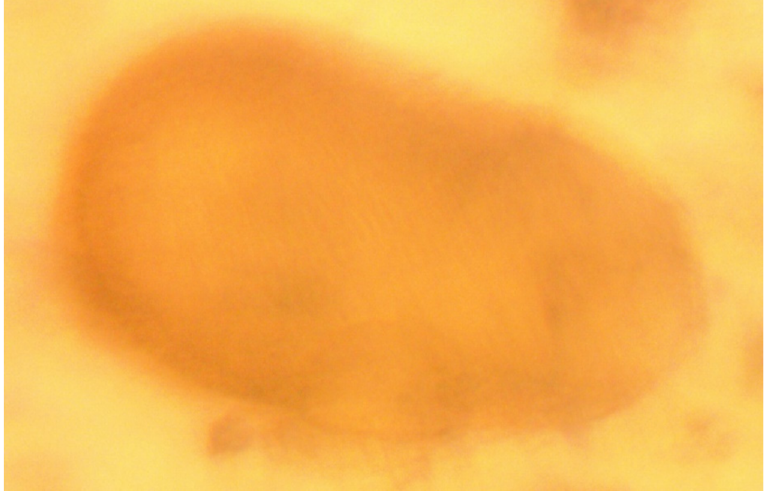
Figure 19. Extracted (from the product water) amorphous, fluid filled, hydrated ellipsoid of metal polymer: transmitted light, field of view = 0.13